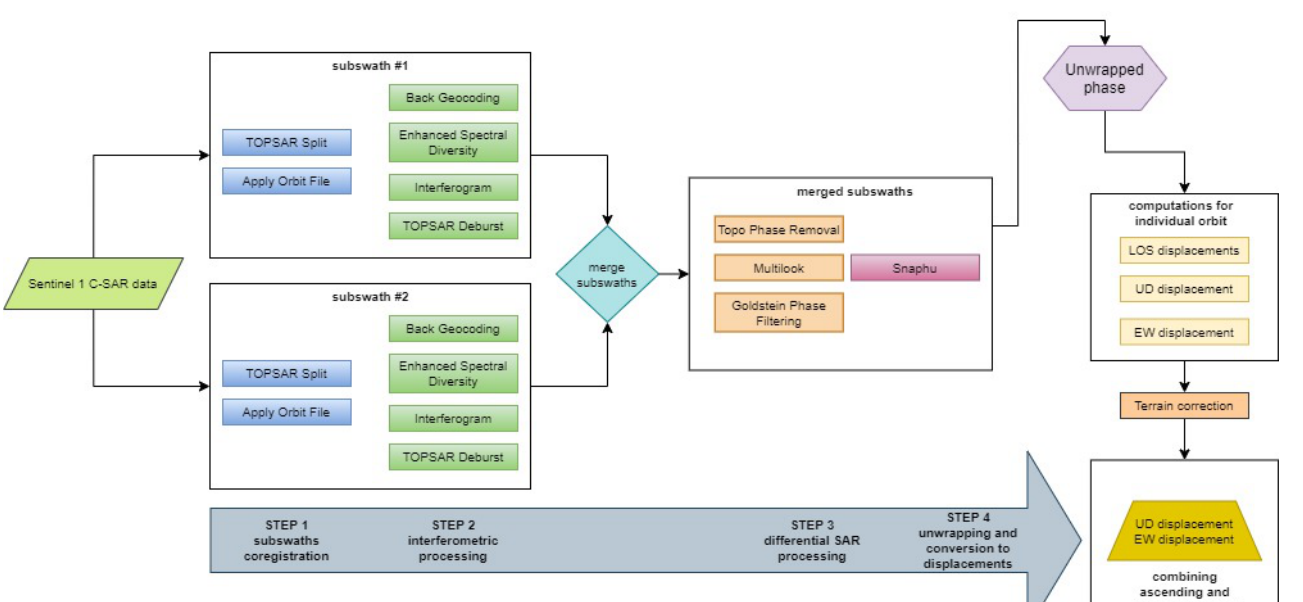
Figure 4. Sentinel-1 SAR processing